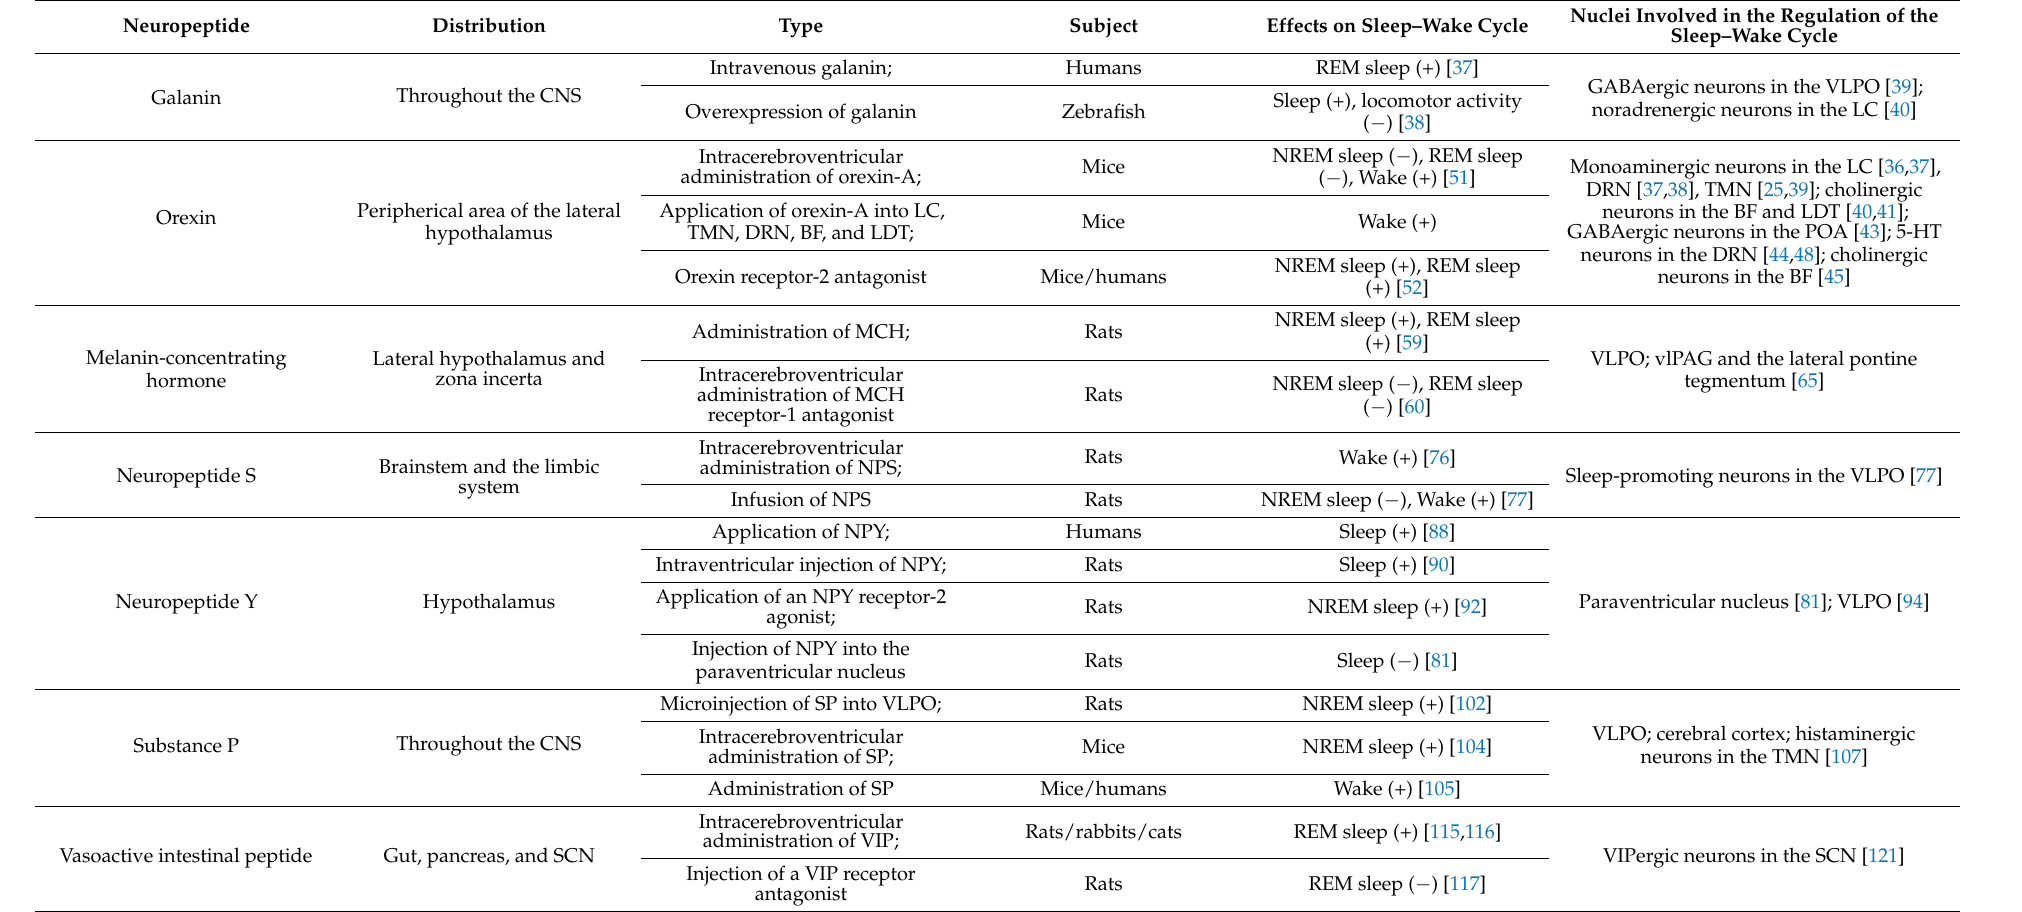
Table 1. The influence of neuropeptides on sleep–wake states and underlying neurobiological